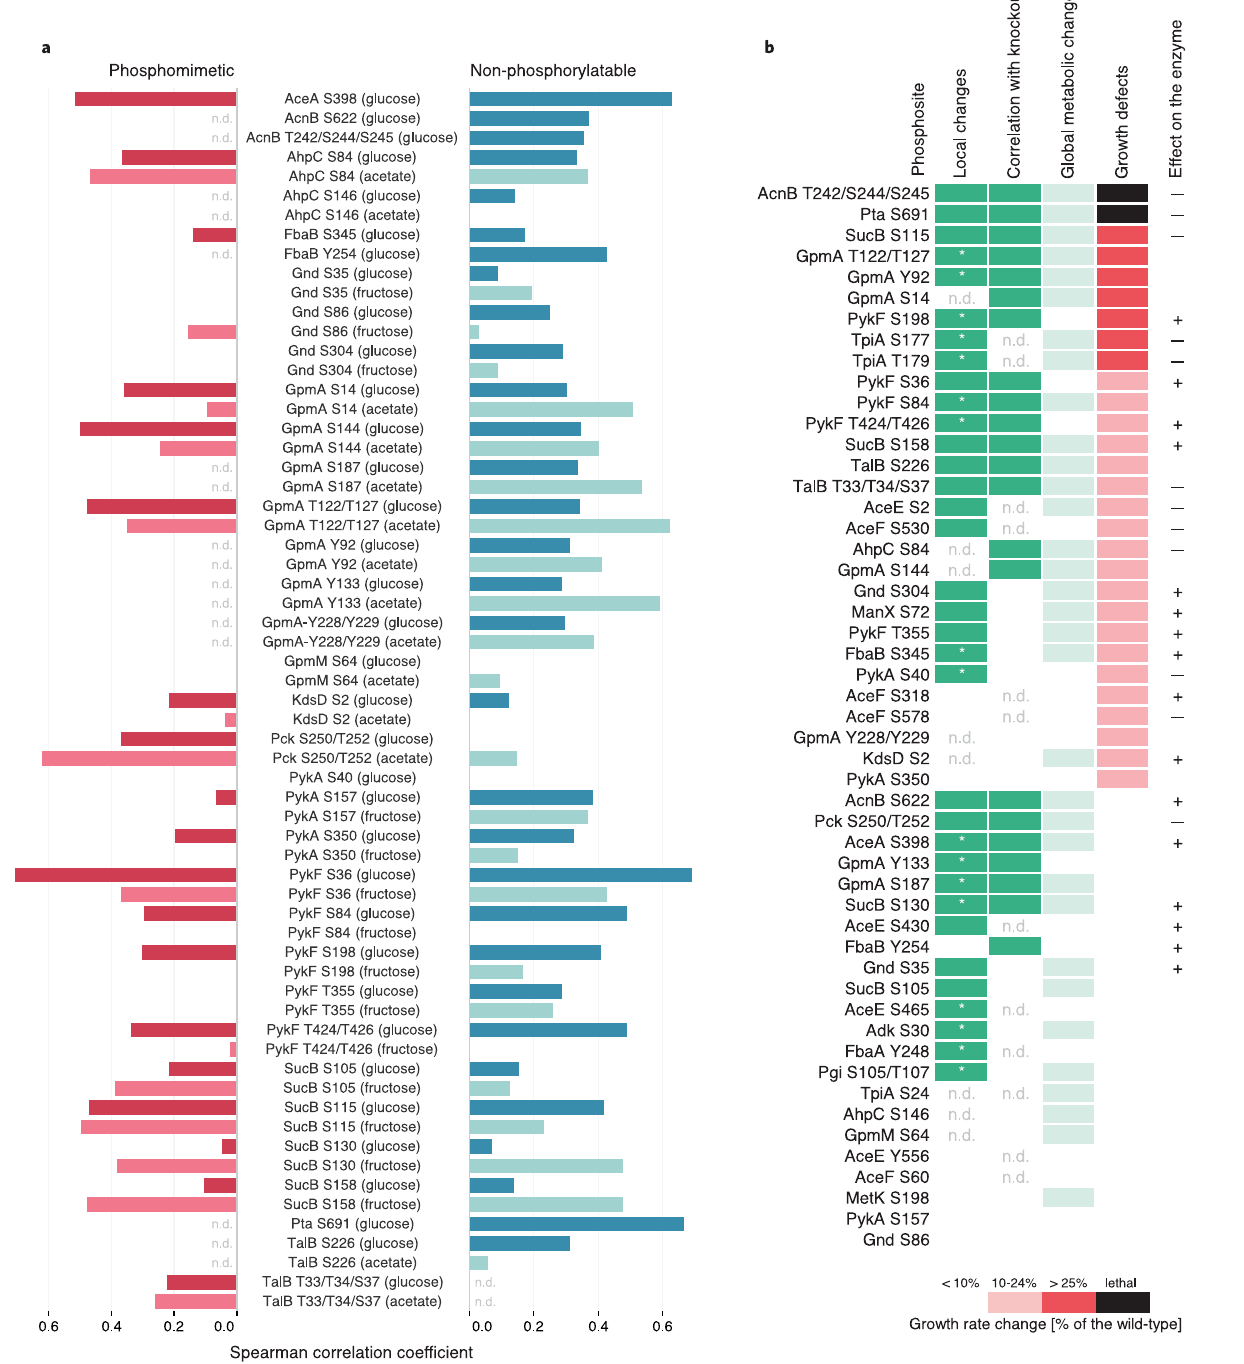
Fig. 2 Metabolic evidence for phosphosite functionality. a Spearman correlation of metabolic pro fi les of phosphomimetic (red) and non-phosphorylatable (petrol) phosphomutants with the corresponding gene knockout. Bright and shaded colors represent glucose and alternative growth conditions, respectively. Negative correlation values are not shown. N.d. — not determined. b Functionality ranking of mutated phosphosites based on phenotypic and metabolic evidence. Metabolic evidence, shown in green, is de fi ned as local changes in reactants or metabolites within fi ve reaction steps from the mutated enzyme (*), and correlation to the metabolic pro fi le of the corresponding gene knockout. Albeit not used for ranking, global metabolic changes de fi ned as at least eight metabolites (twice the median amount of changing metabolites for all phosphomutants in all conditions) are indicated in light green. Where possible, negative ( – ) or positive ( + ) effects of phosphorylation is concluded based on the phenotypic and metabolic evidence for the phosphomutants. N.d. — not